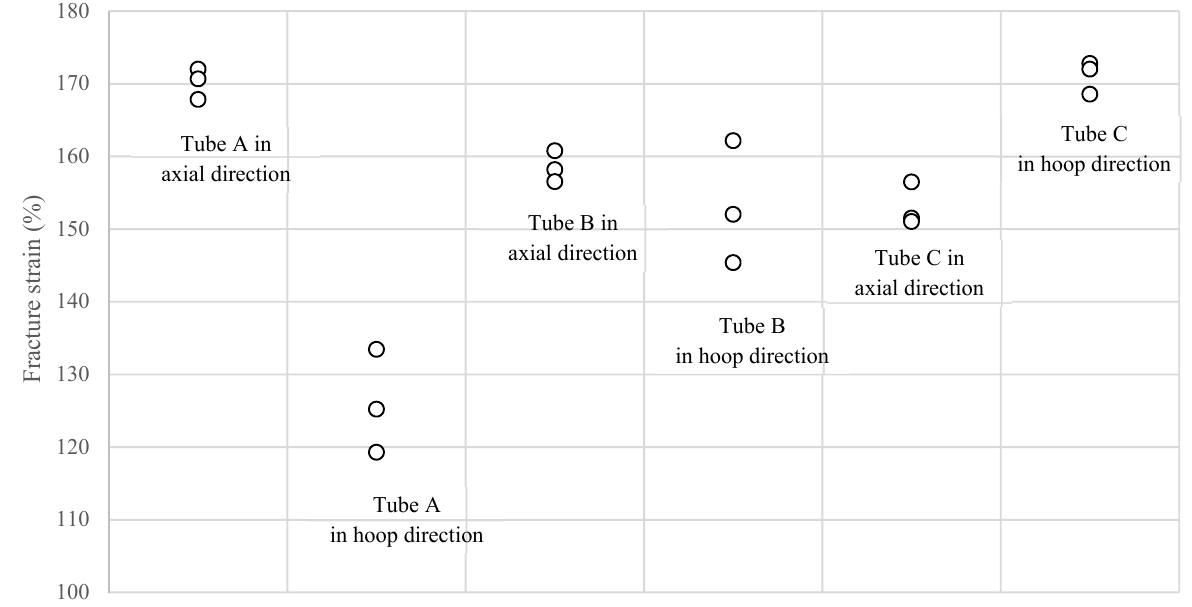
Figure 9. Fracture strain derived from the fracture surface area.